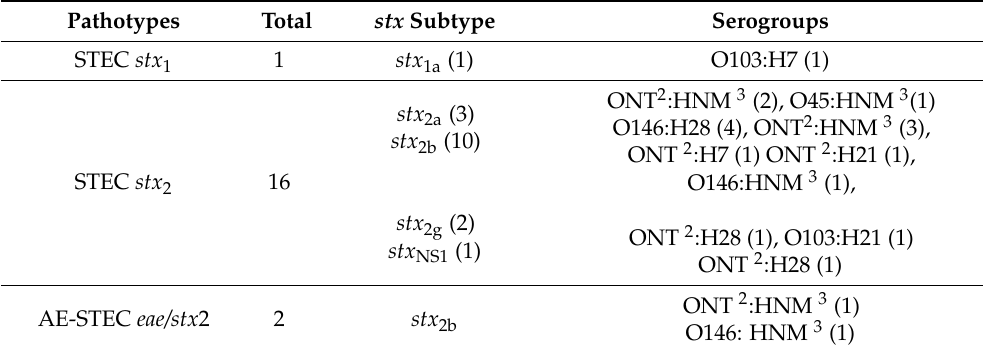
Table 1. Serotype, stx subtype, and the number of isolates harbouring virulence genes in STEC strains isolated from red deer ( Cervus elaphus ) faeces.